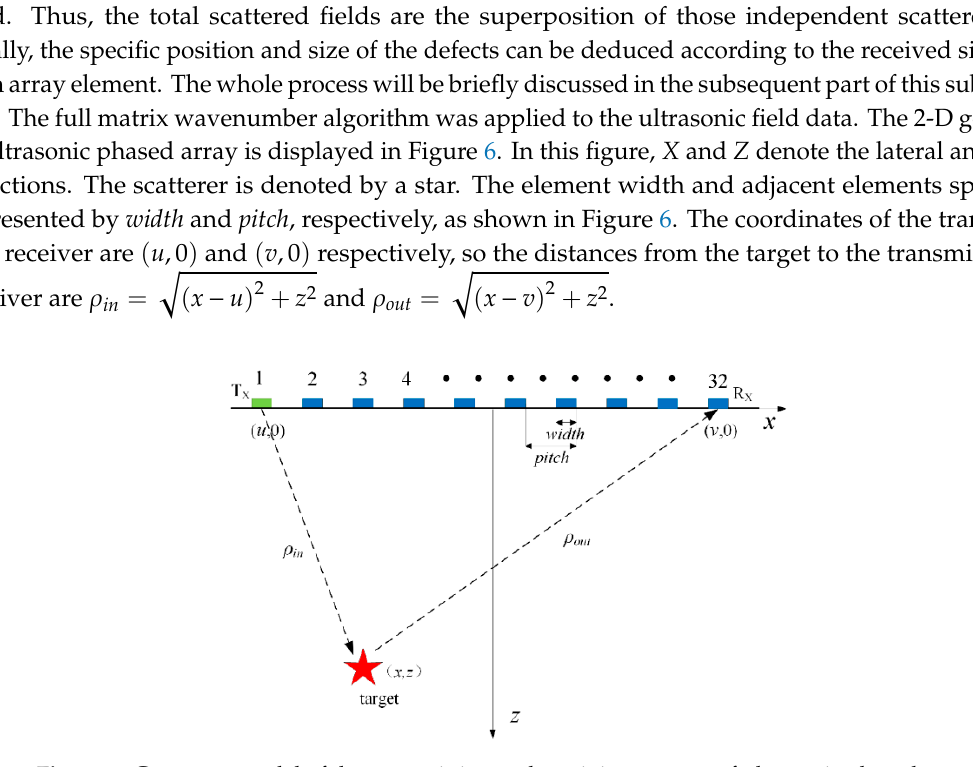
Figure 6. Geometry model of the transmitting and receiving process of ultrasonic phased array.